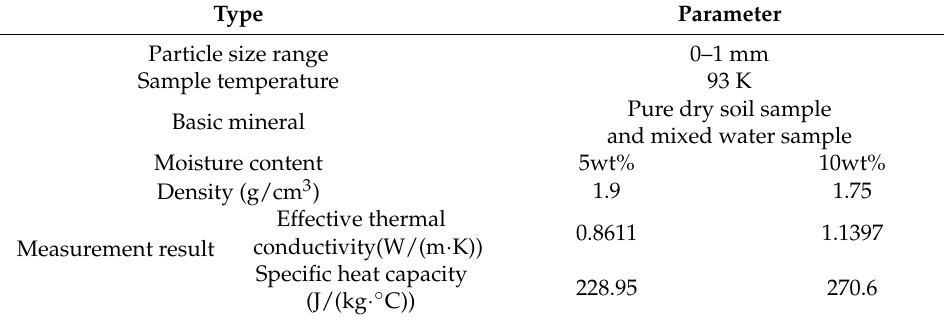
Table 3. Experimental parameters of simulated lunar soil frozen soil.